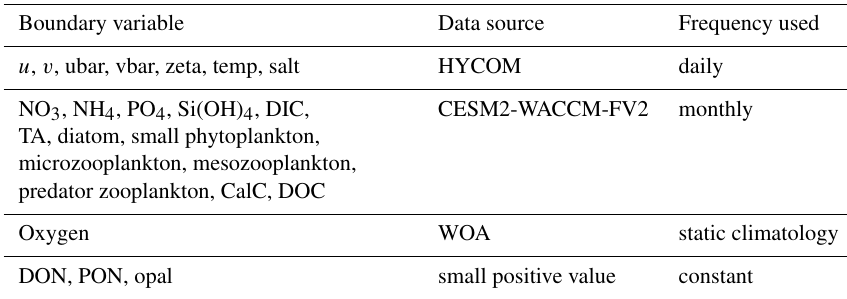
Table A2. Model boundary